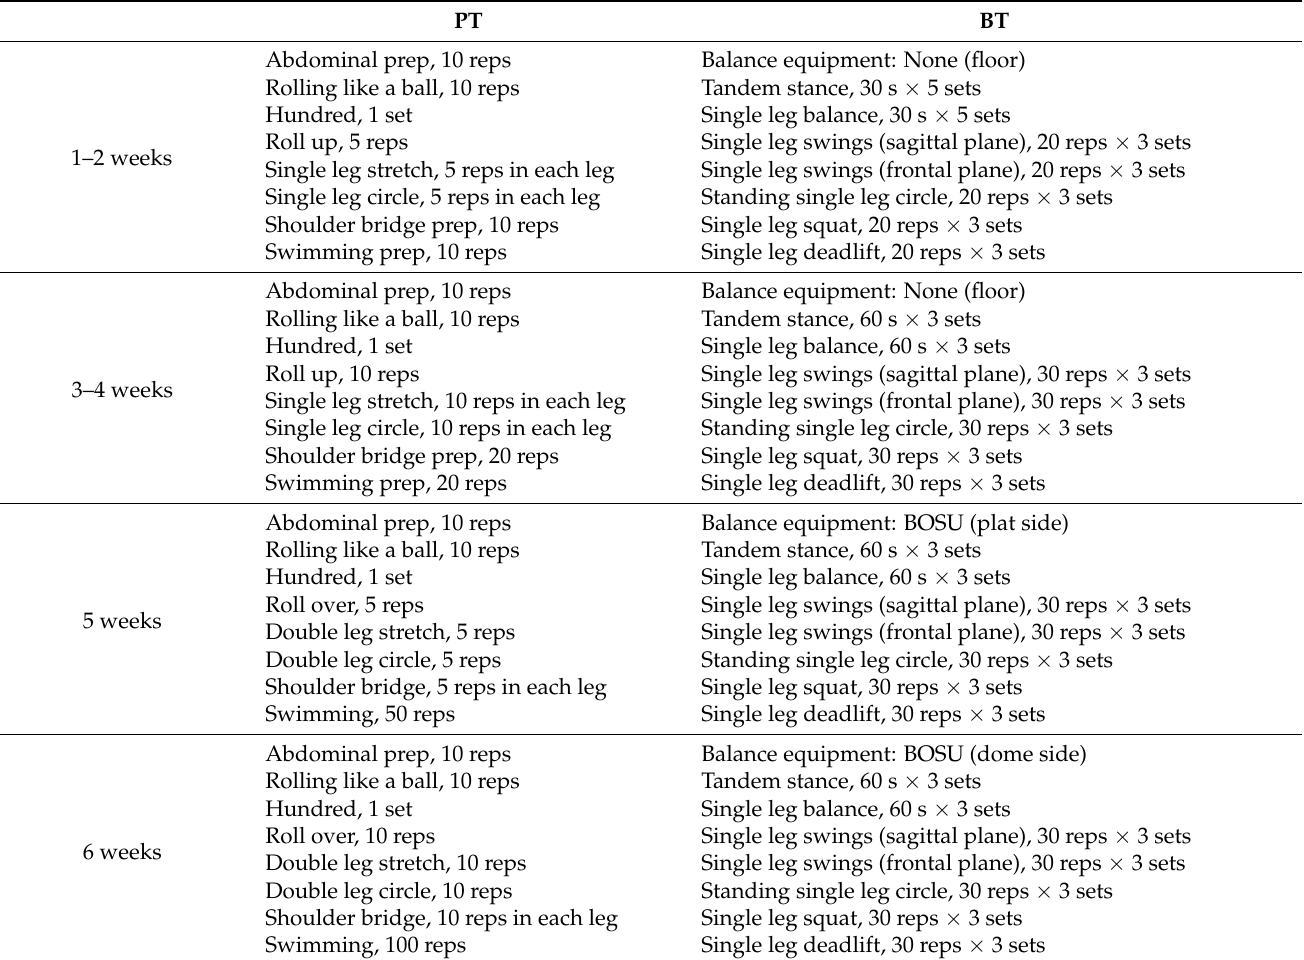
Table 1. Pilates training and balance training